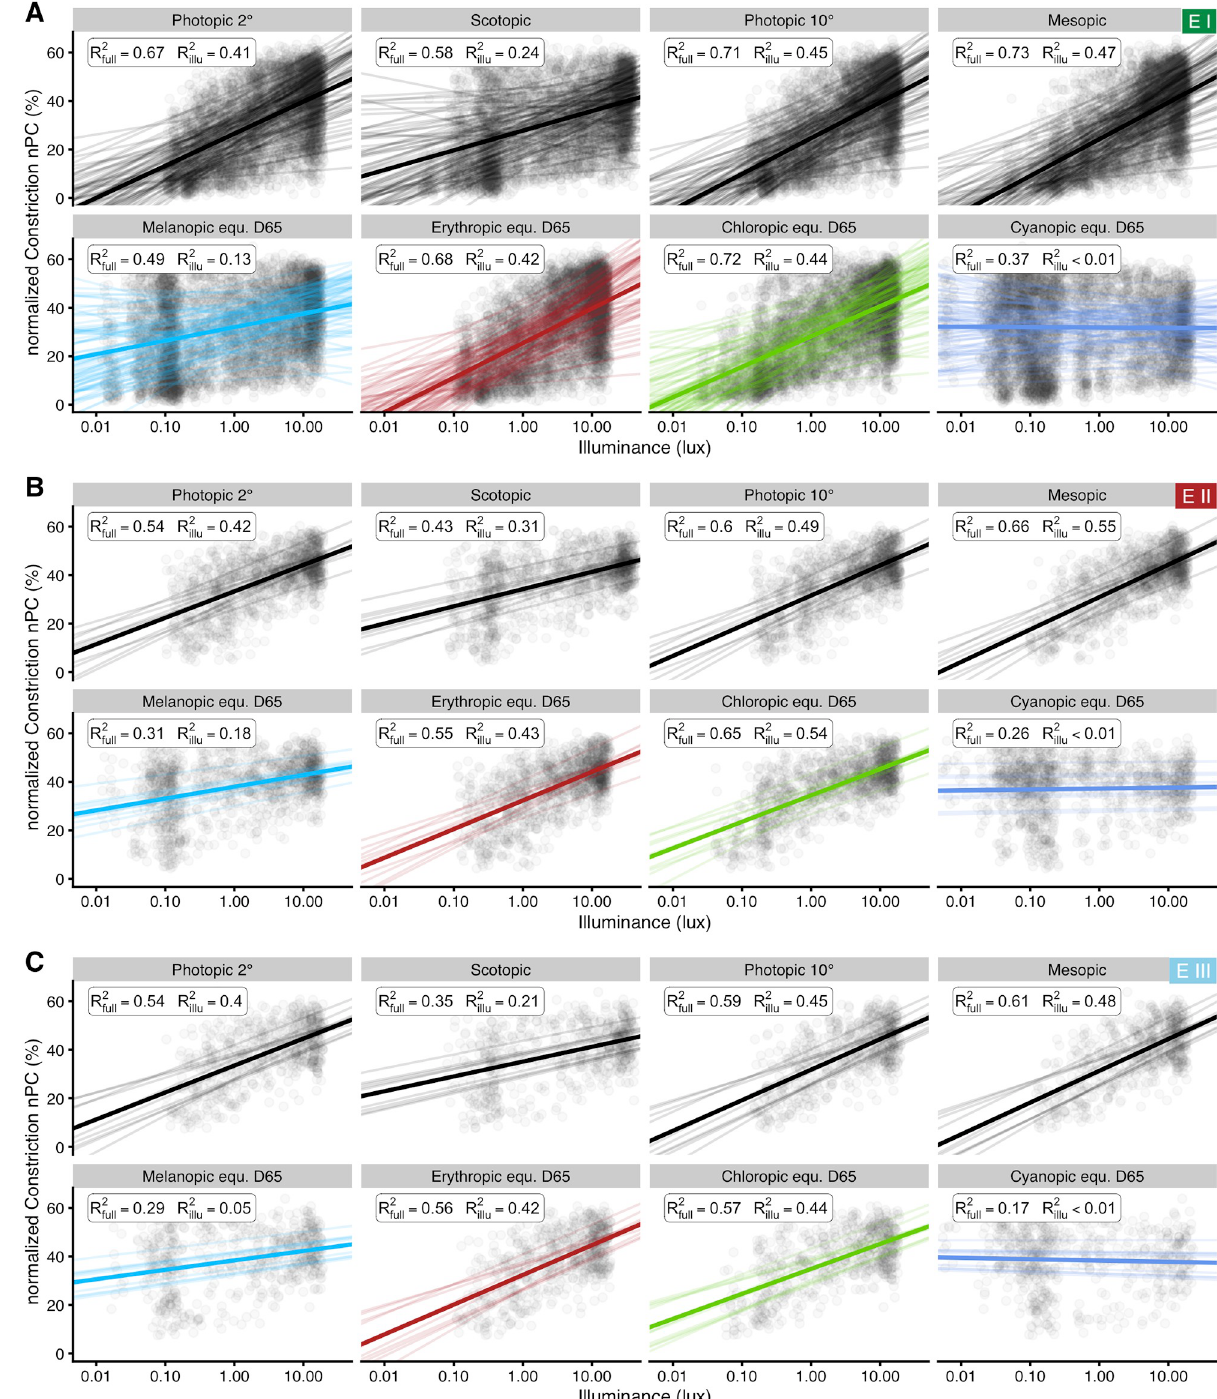
Fig 7. Linear mixed-effect model results for nPC’s dependency on illuminance. Model predictions for nPC vs. various measures of illuminance. Points show individual data. Thick regression lines show the fixed-effect relationship and thin regression lines random effect variation in slope and intercept by participant. The insets show R 2 full for the full model (fixed and random effects), and, more importantly, a partial R 2 illu , i.e. the proportion of variance explained through nPC’s relationship with the fixed effect of illuminance. Part (A) shows results for Experiment I , (B) for protocols with darkness between light steps in Experiment II , and (C) for protocols with thirty seconds of light, followed by nine seconds of darkness in Experiment III .